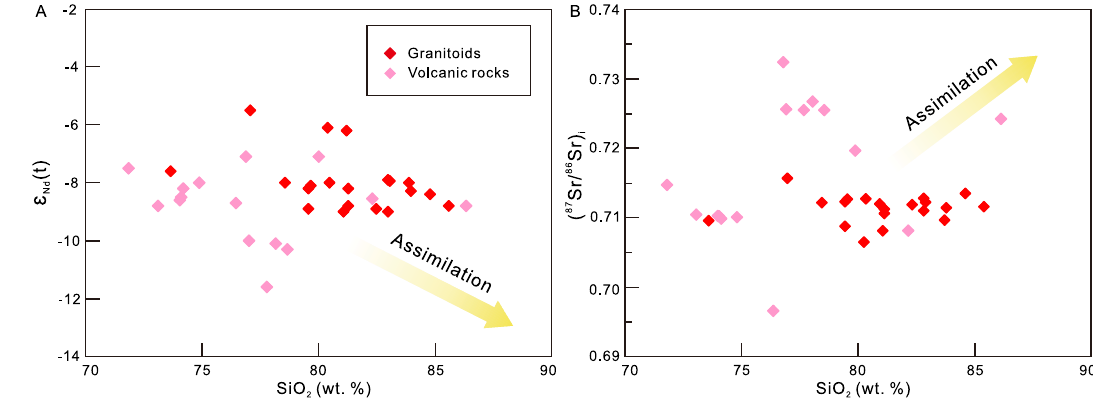
Figure 6. ( A ) SiO 2 versus ε Nd (t) and ( B ) SiO 2 versus ( 87 Sr/ 86 Sr) i diagrams. Whole-rock initial 87 Sr/ 86 Sr ratios and ε Nd (t) show low correlation with SiO 2 .